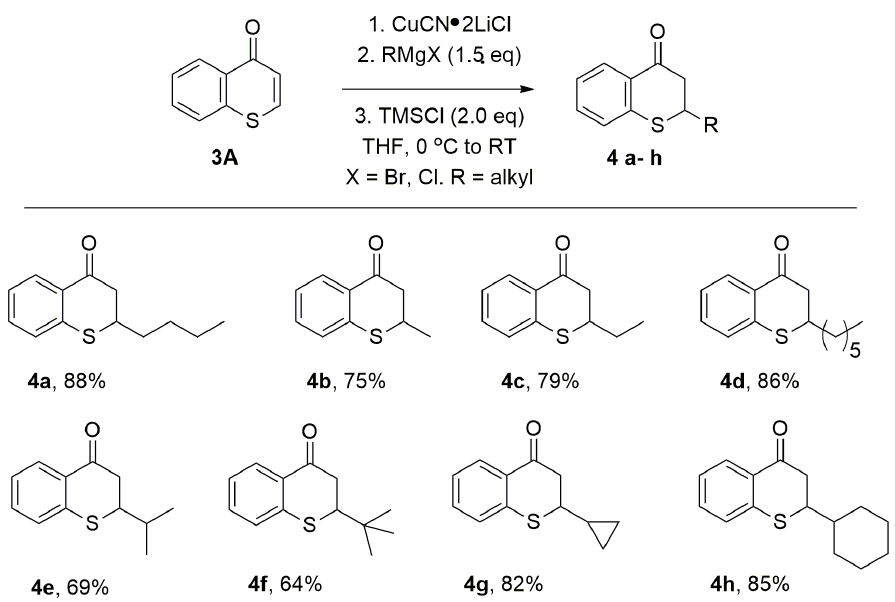
Figure 5. Copper-Catalyzed Conjugate Addition of RMgX to Thiochromones. Under these optimal reaction conditions, aromatic Grignard reagents also underwent conjugate addition to thiochromones smoothly (Figure 6). PhMgBr added to thiochro- mone 3A to in 1,4-additon fashion with high efficiency (Figure 6, 5a , 89%). Grignard rea- gents with electron-donating groups such as “-Me”, “-OMe” on the aromatic ring were found to be effective too ( 5b – d , 80–90%). Grignard reagents with strong electron-with- drawing groups such as “-CF 3 ” on the aromatic ring also worked well in 1,4-addition fash- ion ( 5e , 70%). Grignard reagents prepared from extended aryl bromides also underwent 1,4-conjugate addition to thiochromone 3A smoothly to afford 1,4-adducts with high chemical yields ( 5f , 84%; 5g , 78%). Furthermore, Grignard reagents prepared from corre- sponding aromatic heterocycle halides such as 2-furyl)magnesium bromide and 2-thienyl- magnesium bromide were also tolerated ( 5h, 79%; 5i , 75%, Figure 6) [58].